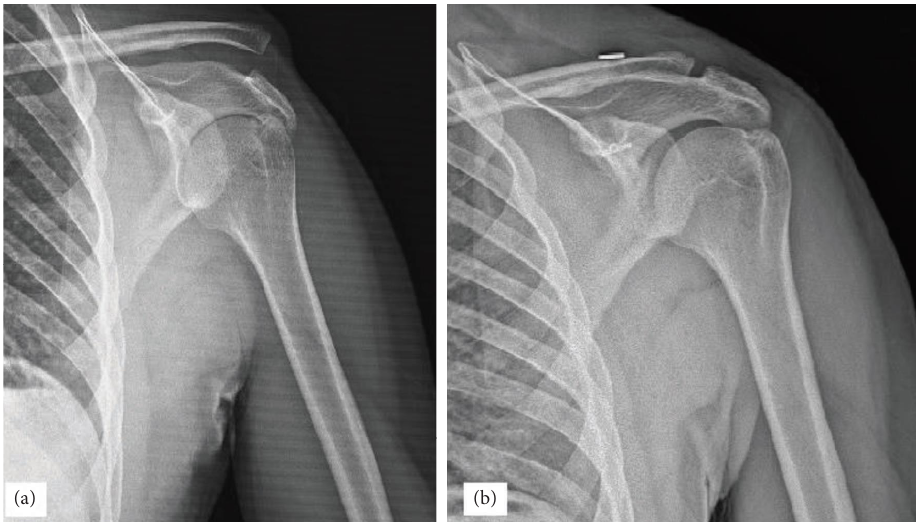
Figure 4: (a) Te preoperative anterior and posterior view of a 42-year male patient, who had Rockwood type III acromioclavicular joint dislocation at his left shoulder due to the fall from standing height. (b) 6-month postoperative plain radiograph showing good maintenance of joint reduction with minimally invasive TightRope.